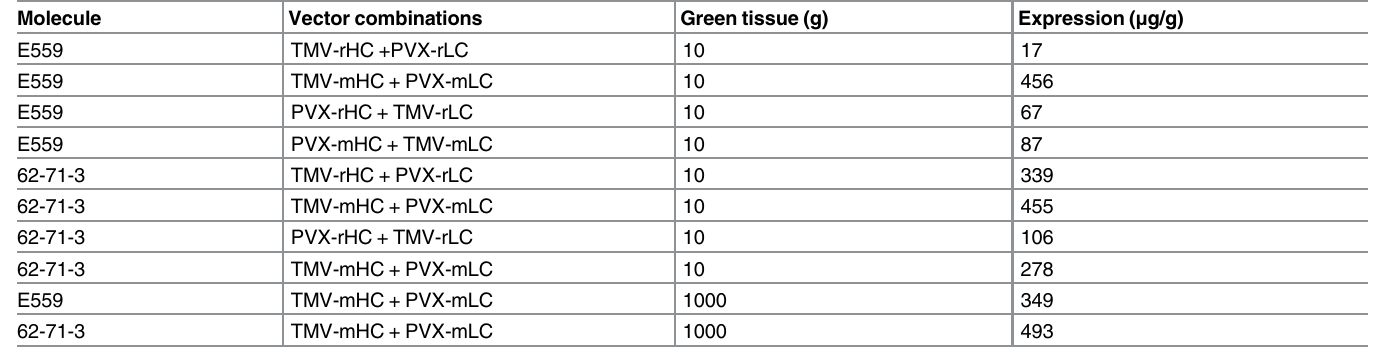
Table 1. MAb E559 and 62-71-3 expression levels obtained using various combinations of either PVX or TMV-based expression vectors with either the murine (m) or rice alpha amylase (r) signal peptide. Molecule Vector